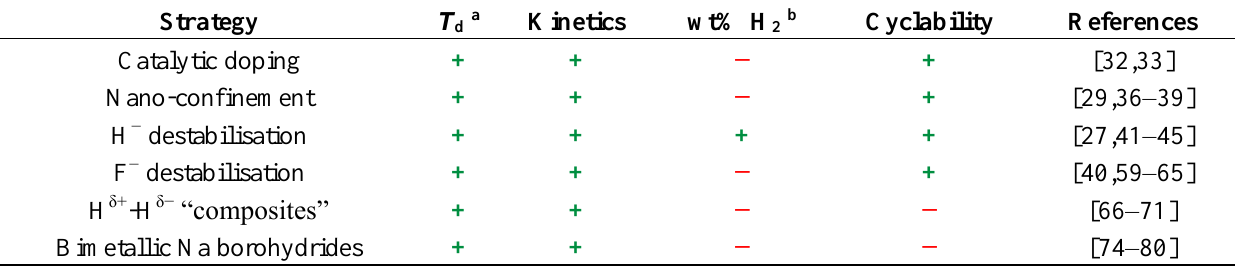
Table 3. Comparison of materials modification approaches relative to NaBH 4 itself (where “+” signifies an improvement and “−” signifies a